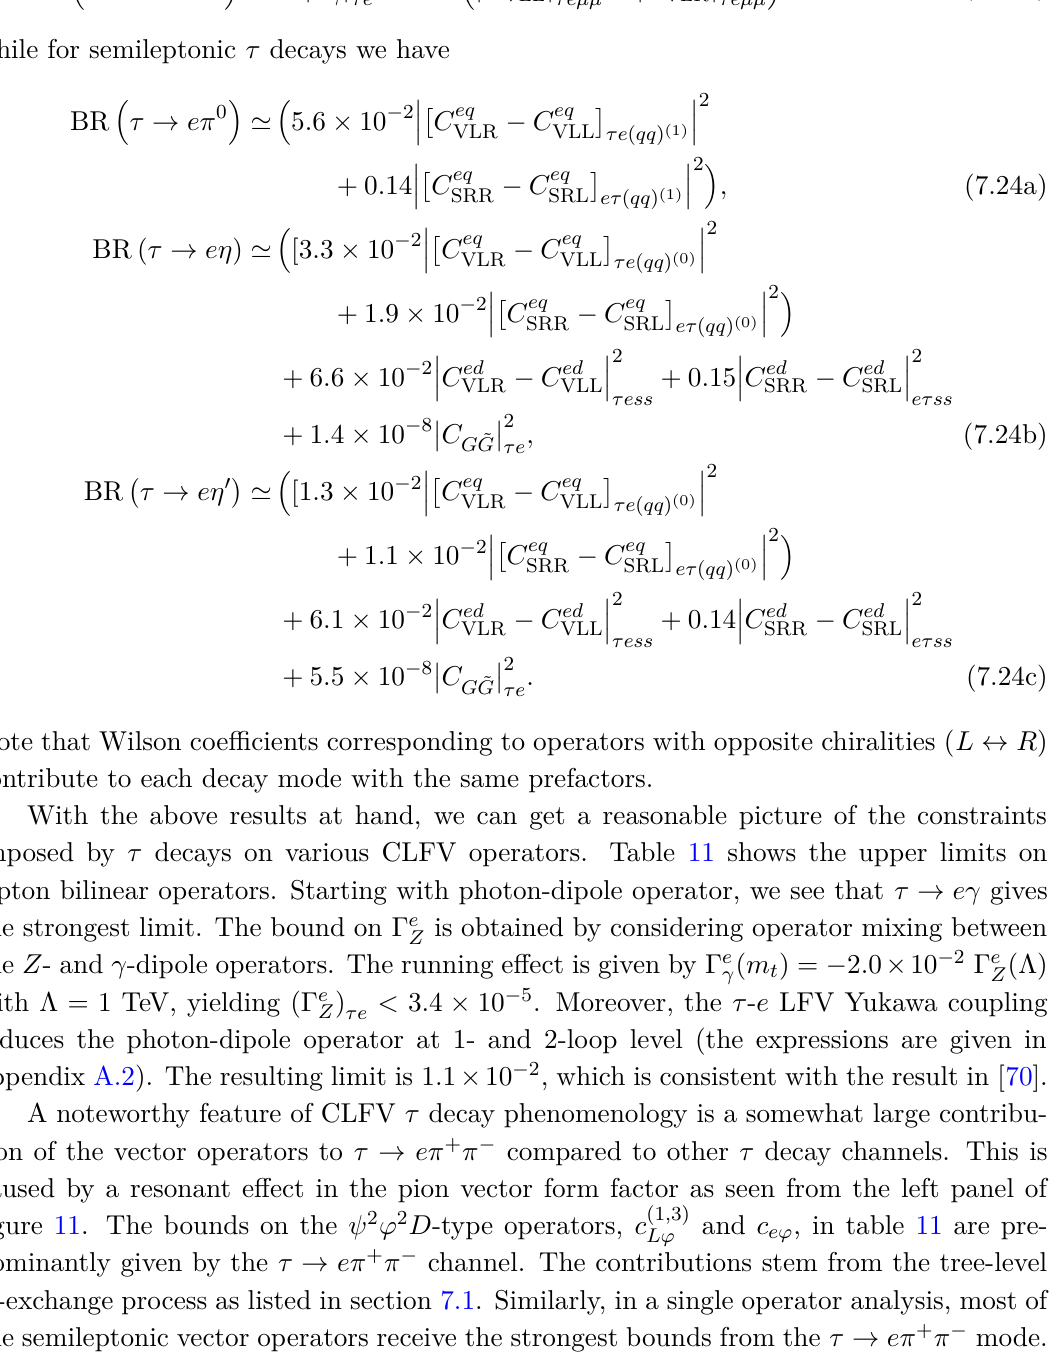
figure 11. The bounds on the ψ 2 ϕ 2 D -type operators, c (1 , 3)